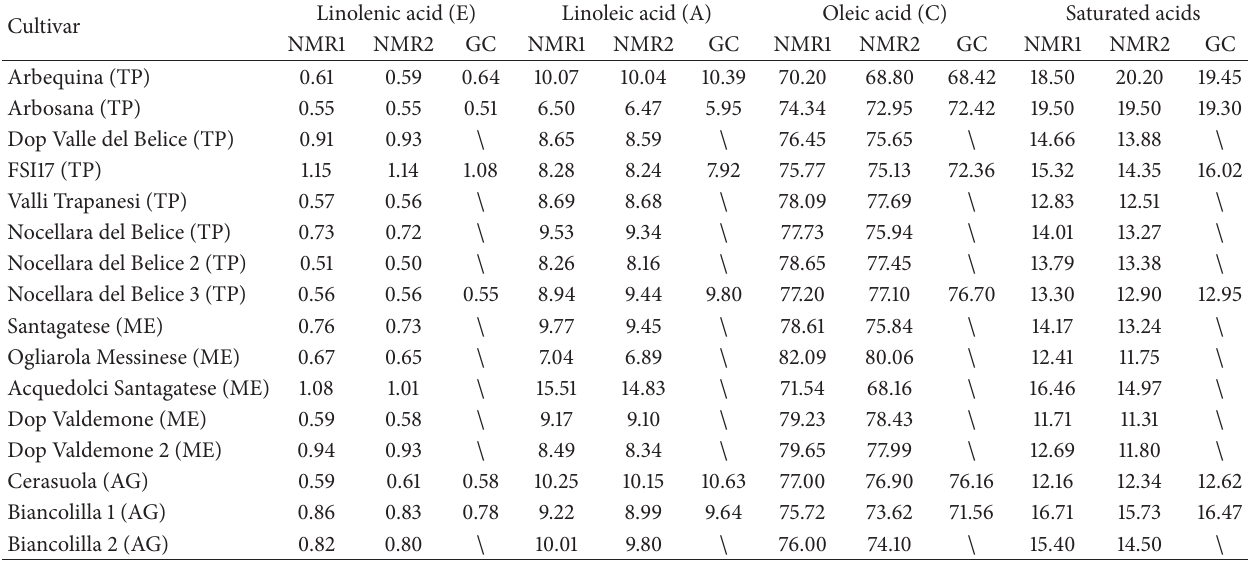
Table 3: Fatty acids percentage in Sicilian eVOOs determined by the two considered methods compared with that obtained by GC on some of them. See text for labels explanation.